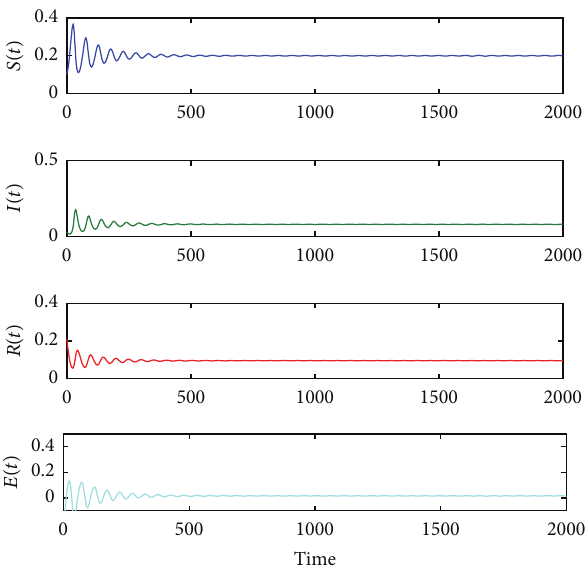
Figure 4: Dynamical responses of model system (4) with time delay 𝜏 = 1.54 , which shows that model system (4) is stable around (0.2, 0.08, 0.0907, 0.0147) .